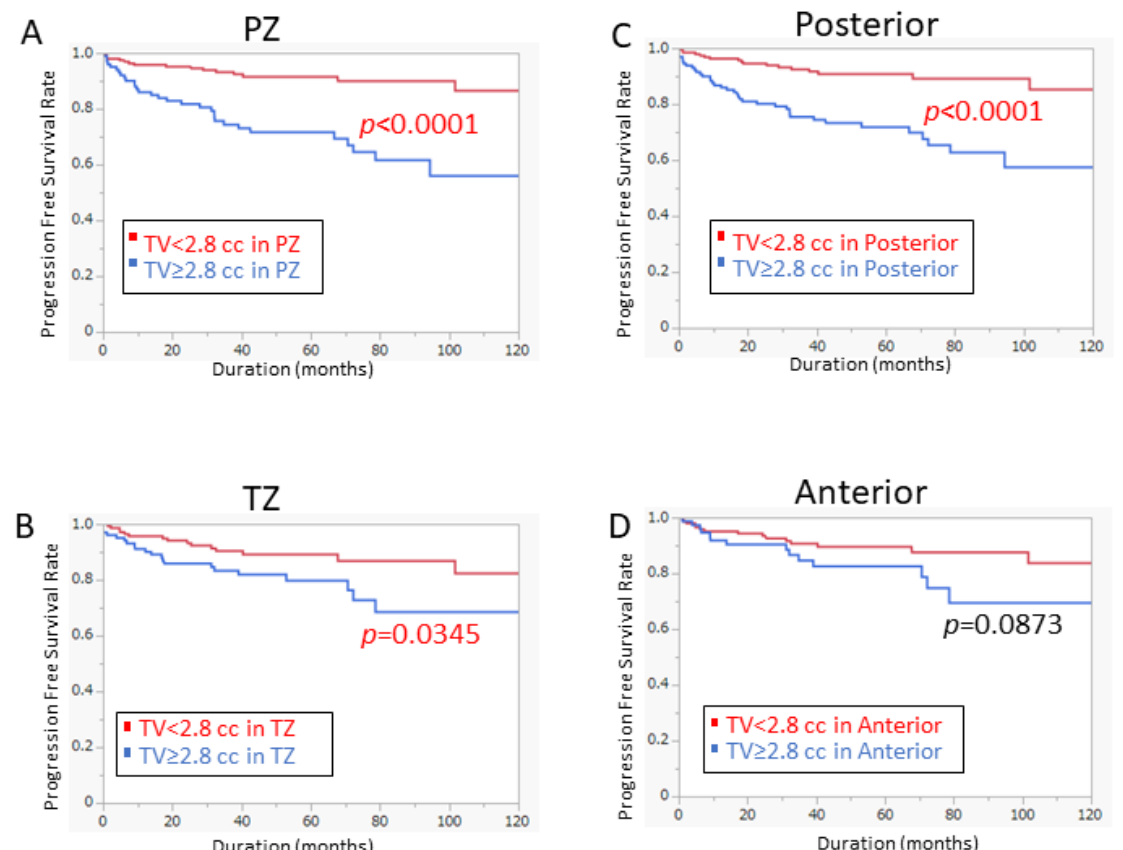
Figure 4. Prognostic significance of Tumor volume 2.8 cc based on the location. ( A ) Patients with tumor volume ≥ 2.8 cc had significantly worse PFS in the PZ ( p < 0.0001). ( B ) Patients with tumor volume ≥ 2.8 cc had significantly worse PFS in the TZ ( p = 0.0345). ( C ) Patients with tumor volume ≥ 2.8 cc had significantly worse PFS in the posterior region ( p < 0.0001). ( D ) In the anterior region, there was no difference in PFS by tumor volume cutoff of 2.8 cc.